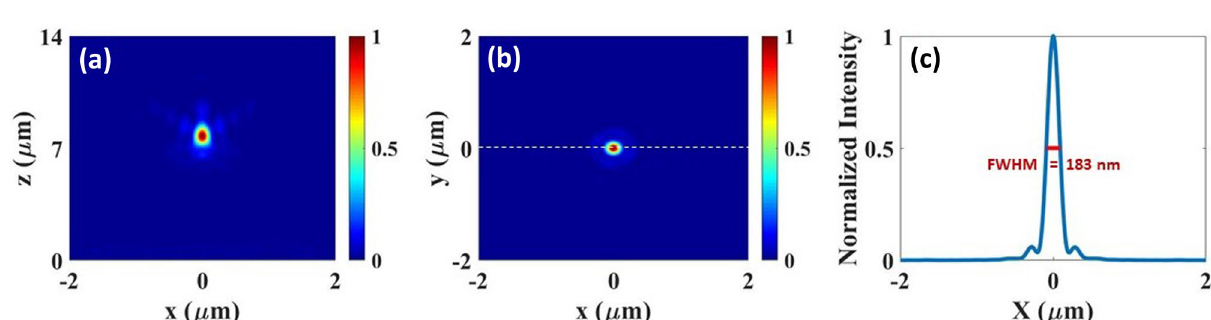
Figure 5. Focusing characteristics of the simple metalens when illuminated by an RCP broadband incident light beam ( (cid:31) = 200 –400 nm). Normalized intensity profiles of focal spot ( a ) ( x − z plane) at y = 0 , ( b ) ( x − y plane) at z = 7.76 µ m, ( c ) corresponding horizontal cut at y = 0 shows FWHM of 183